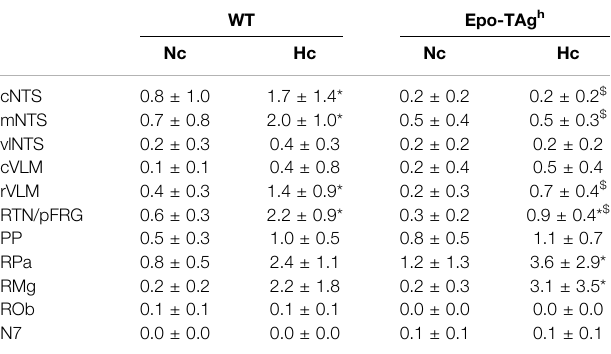
TABLE 1 | Average number of C-FOS-positive cells in respiratory areas of the medulla oblongata under normocapnia (Nc) and hypercapnia (Hc) in male wild type (WT) and Epo-TAg h